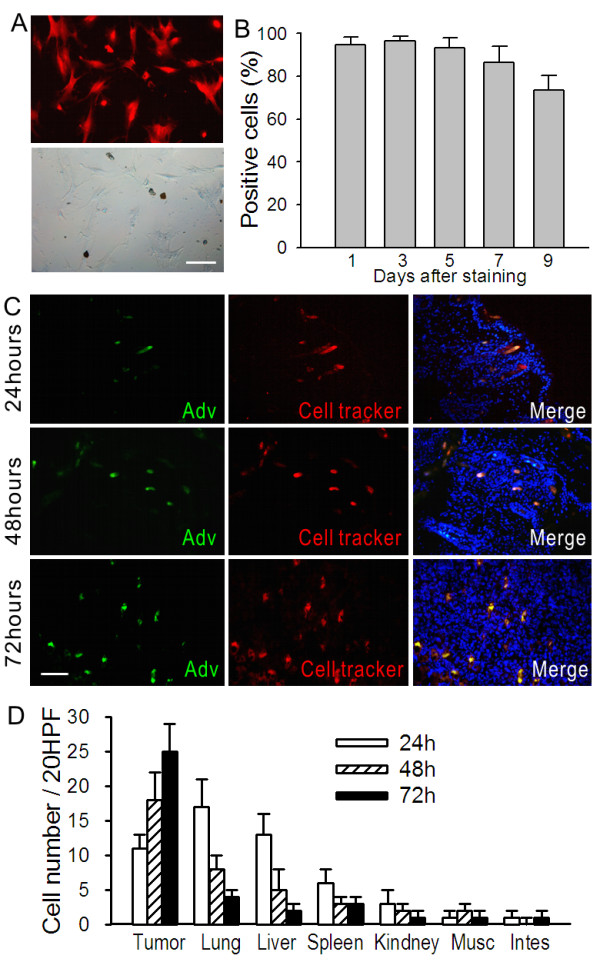
Kinetic distribution of Adv-Stat3(-)-loaded MSCs in a breast orthotopic tumor model. (A) MSCs labeled with 5 μM Cell Tracker Red. The cells were observed under a fluorescent microscope after 24 hours (upper panel). The corresponding bright field is shown in the lower panel. Scale bar = 15 μm. (B) Labeling efficiencies of MSCs with Cell Tracker Red at the indicated time points as evaluated by FACS were expressed as mean ± SD in three independent experiments. (C) Representative images showing the distribution of Adv-Stat3(-)-loaded MSCs in an orthotopic tumor. 1 × 106 Cell Tracker Red labeled MSCs were infected with 500 MOI Ade-Stat3(-). Six hours later, these cells were intravenously injected into tumor-bearing mice. The mice were sacrificed and frozen sections of tumor prepared and incubated with FITC-labeled adenovirus hexon antibody after 24 (upper panels), 48 (middle panels), and 72 (lower panels) hours. The sections were counterstained with DAPI and observed under a fluorescent microscope. Scale bar = 20 μm. (D) Cell number of MSCs in normal tissue from the mice in panel c at the indicated time points. After incubating frozen sections with FITC-labeled adenovirus hexon antibody, the sections were observed under a fluorescent microscope. The number of MSCs were counted under ×20 HPF in five random fields and expressed as mean ± SD (n = 3).